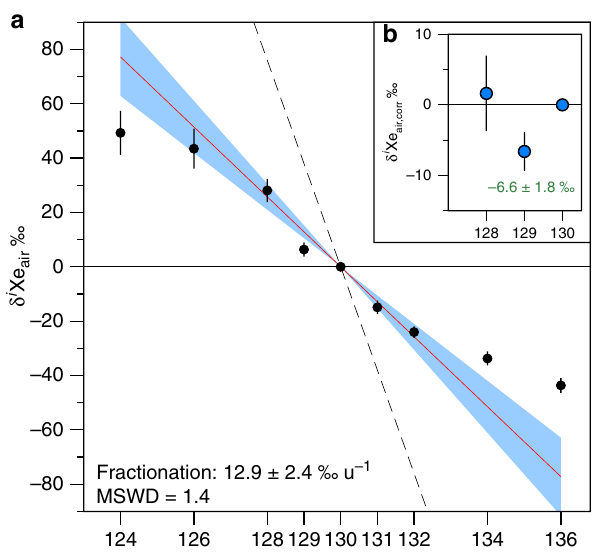
Figure 4 | Isotopic composition of xenon in Barberton quartz samples. ( a ) Isotope spectrum of xenon in Barberton quartz samples (error-weighted average on 27 measurements) relative to the isotopic composition of the modern atmosphere and expressed using the delta notation ( d i Xe air ¼ (( i Xe/ 130 Xe) Barb. /( i Xe/ 130 Xe) air (cid:2) 1) (cid:3) 1,000). The computed isotopic fractionation (12.9 ± 2.4 % u (cid:2) 1 ( ± 2 s )) is shown as a red line with its 2 s error envelope in blue. The dashed line corresponds to the isotopic fractionation of SW-Xe relative to the air (38 % u (cid:2) 1 , ref. 33). MSWD is mean square weighted deviation. Note the depletion in 129 Xe relative to the mass fractionation corresponding to lower radiogenic 129 Xe excess in the Archean atmosphere. Errors at 2 s . ( b ) Isotope spectrum of 128 Xe and 129 Xe normalized to the isotopic composition of the modern atmosphere (see above) in Barberton quartz samples and corrected for the isotopic fractionation of 12.9 ± 2.4 % u (cid:2) 1 ( ± 1 s , s.e.m.) ( d i Xe air,corr ). The 129 Xe depletion ( (cid:2) 6.6 ± 1.8 % ( ± 1 s , s.e.m.)) corresponds to a degassing rate of 8 ± 4 ( ± 1 s , s.d.) mola (cid:2) 1 of radiogenic 129 Xe produced by the decay of now extinct 129 I ( T 1/2 ¼ 16Ma). Errors at 1 s .